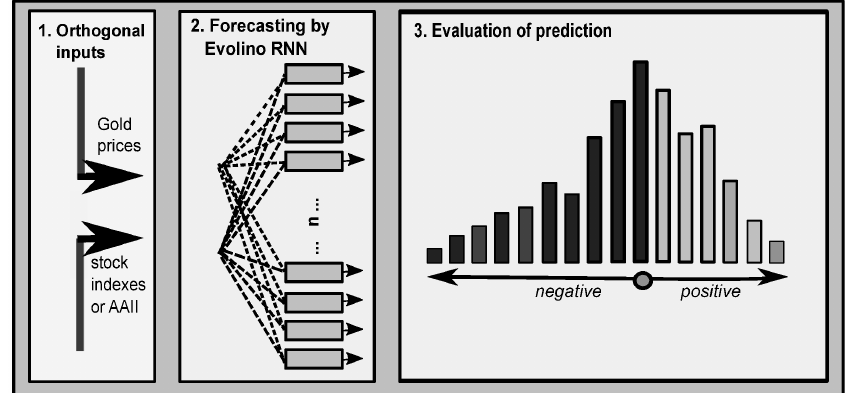
Figure 1. Scheme of the distribution-based